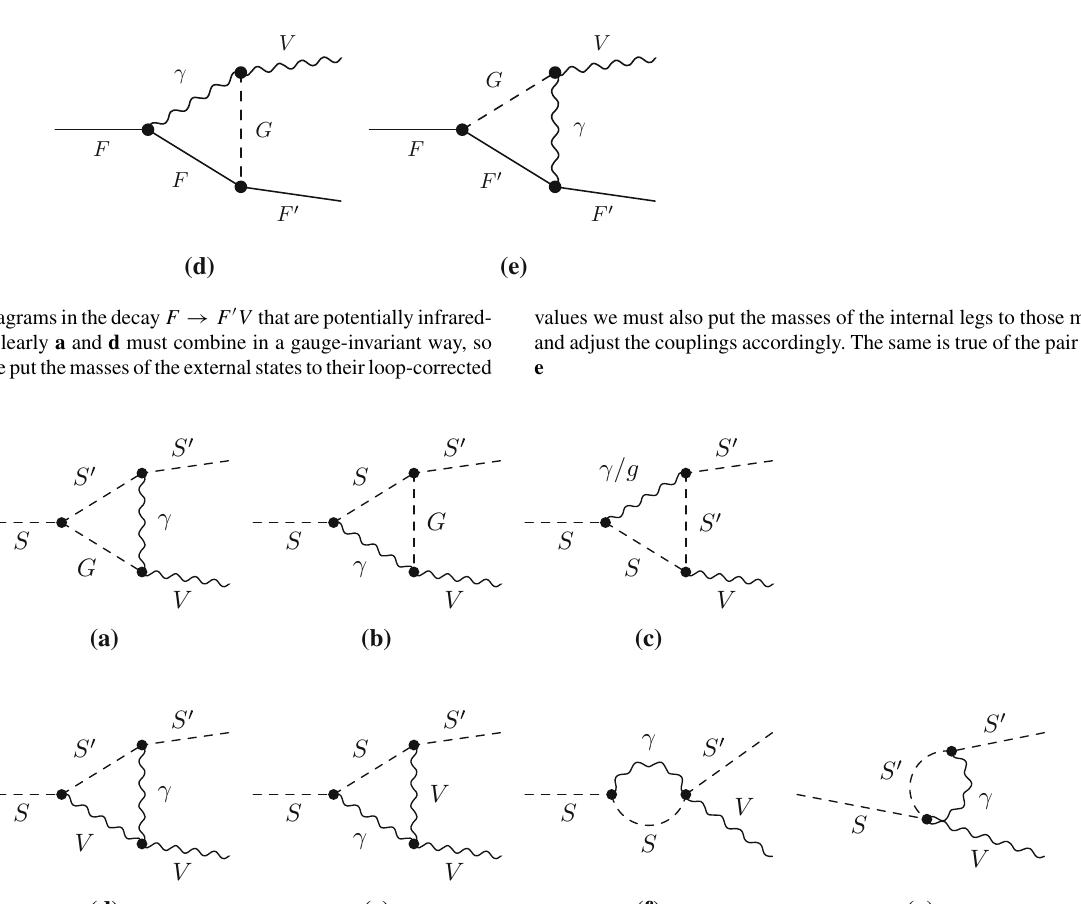
Fig. 22 Diagrams in the decay S → S (cid:5) V containing a massless gauge boson propagator. The picture is almost identical to the fermion case, except that we have more “benign” diagrams ( f ) and ( g